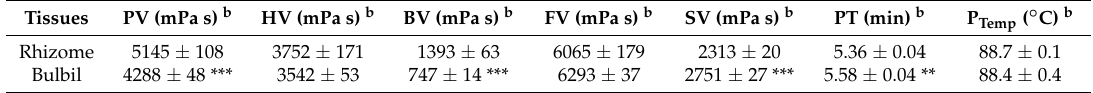
Table 5. Pasting properties of starches a .